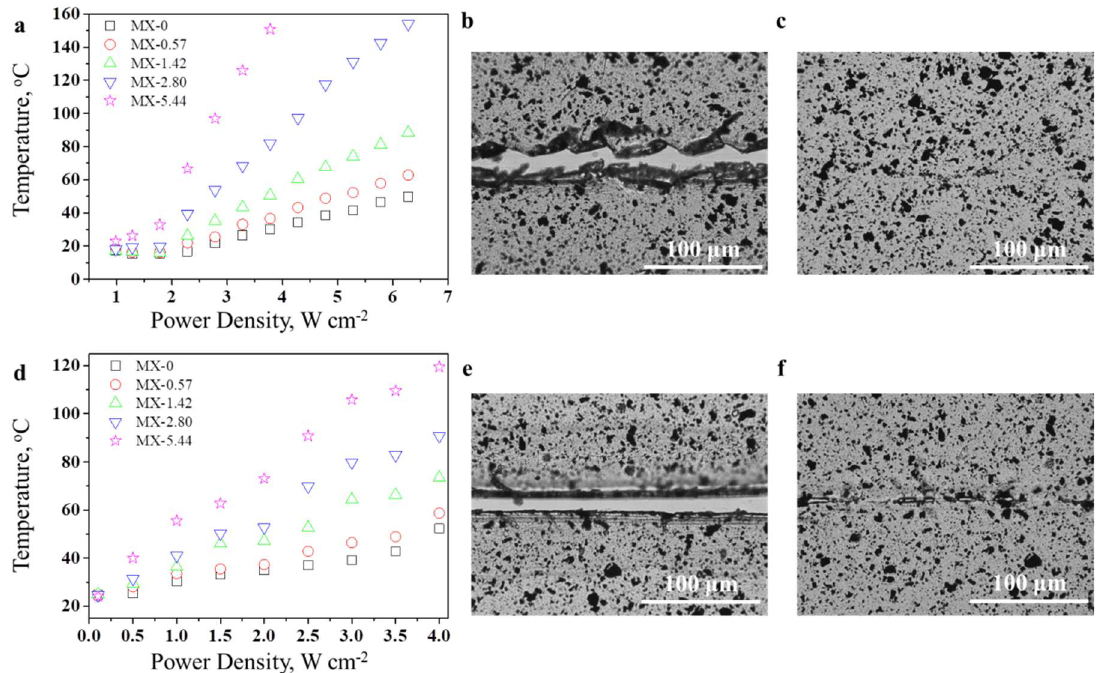
Figure 9. ( a ) Relation between temperature and 808 nm near-infrared (NIR) light power density; ( b , c ) Optical images of MX-2.80 having a crack ( b ) before and ( c ) after irradiation at 6.28 W cm − 2 for 10 s; ( d ) Relation between temperature and focused sunlight power density; ( e , f ) Optical images of MX-2.80 having a crack ( e ) before and ( f ) after irradiation at 4 W cm − 2 for 10 min.